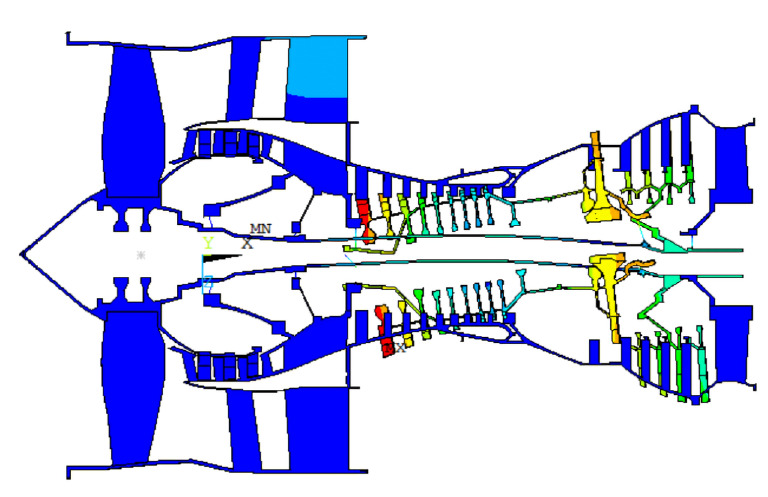
Figure 10. The second critical speed modal shape. Figure 11. The third critical speed modal shape. Figure 11. The third critical speed modal